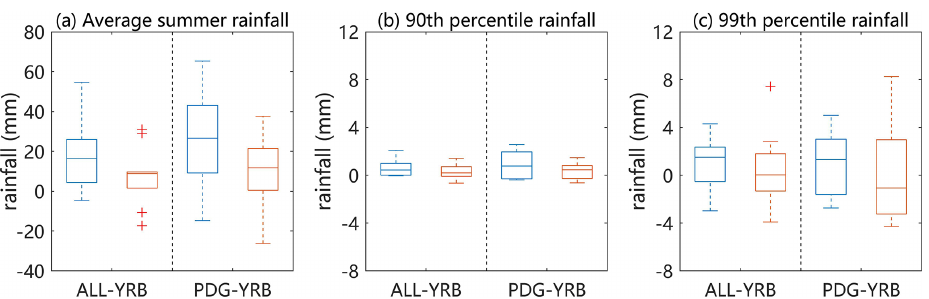
Figure 10. The changes in (a) average summer rainfall (mm), (b) 90th percentile summer rainfall (mmd − 1 ), and (c) 99th percentile summer rainfall (mmd − 1 ) between the two hypothetical scenarios (20% and 50% scenarios) and the 2010 scenario in the ALL-YRB and PDG-YRB area. The blue boxes represent the 20% scenario, while the red boxes represent the 50% scenario.